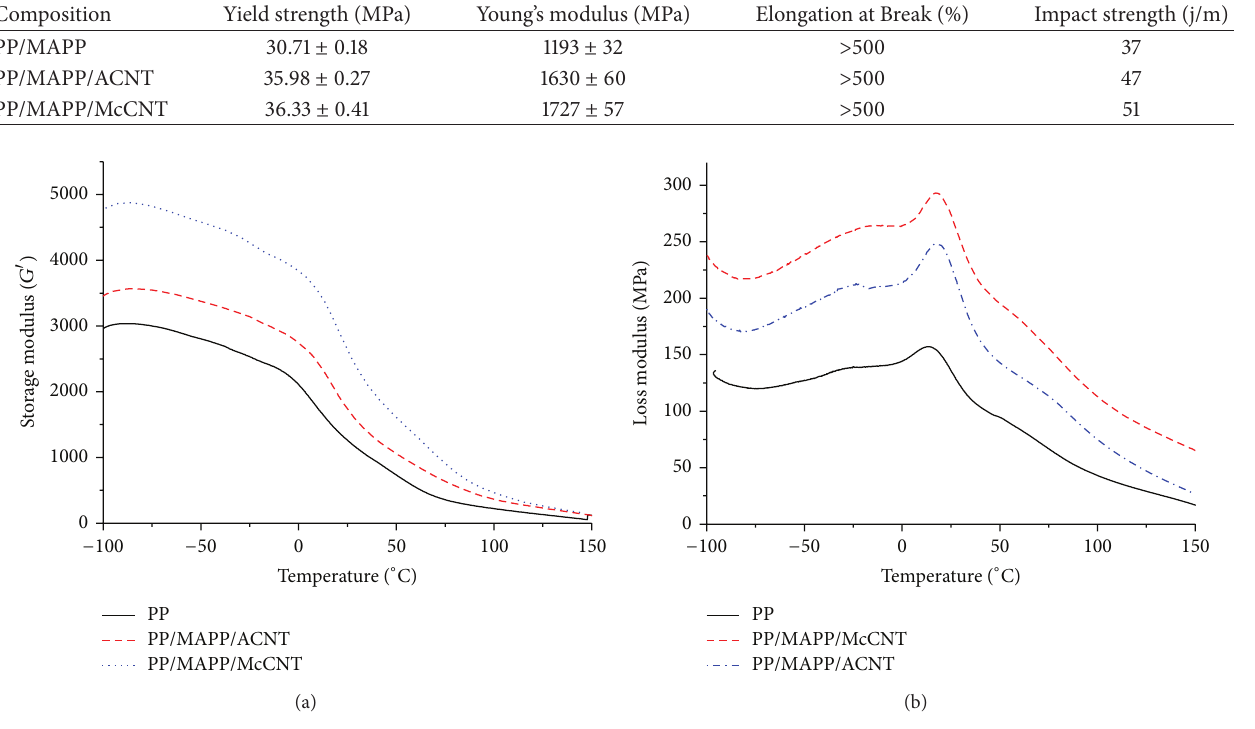
Figure 4: Storage modulus and loss modulus of PP and its